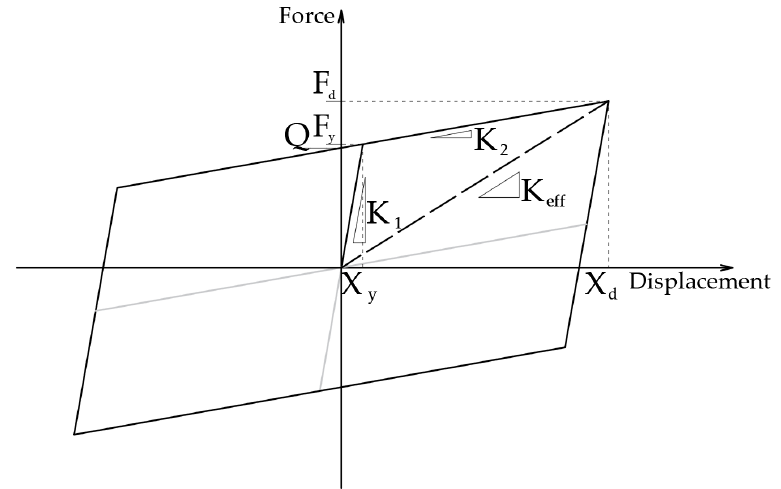
Figure 3. Force-displacement curve of a typical isolation device.